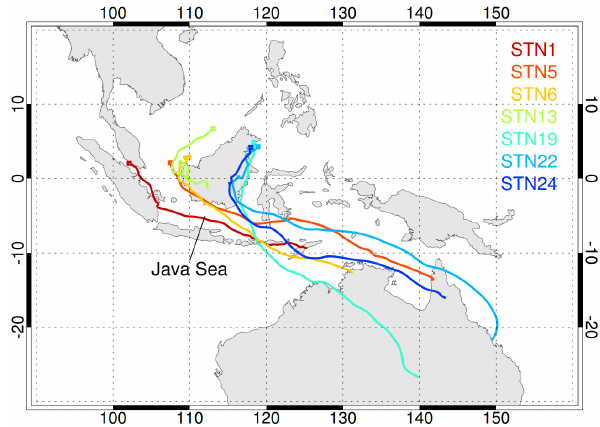
Figure 3. Ten-day air distribution backward trajectories calculated from the NOAA HYSPLIT model for each selected